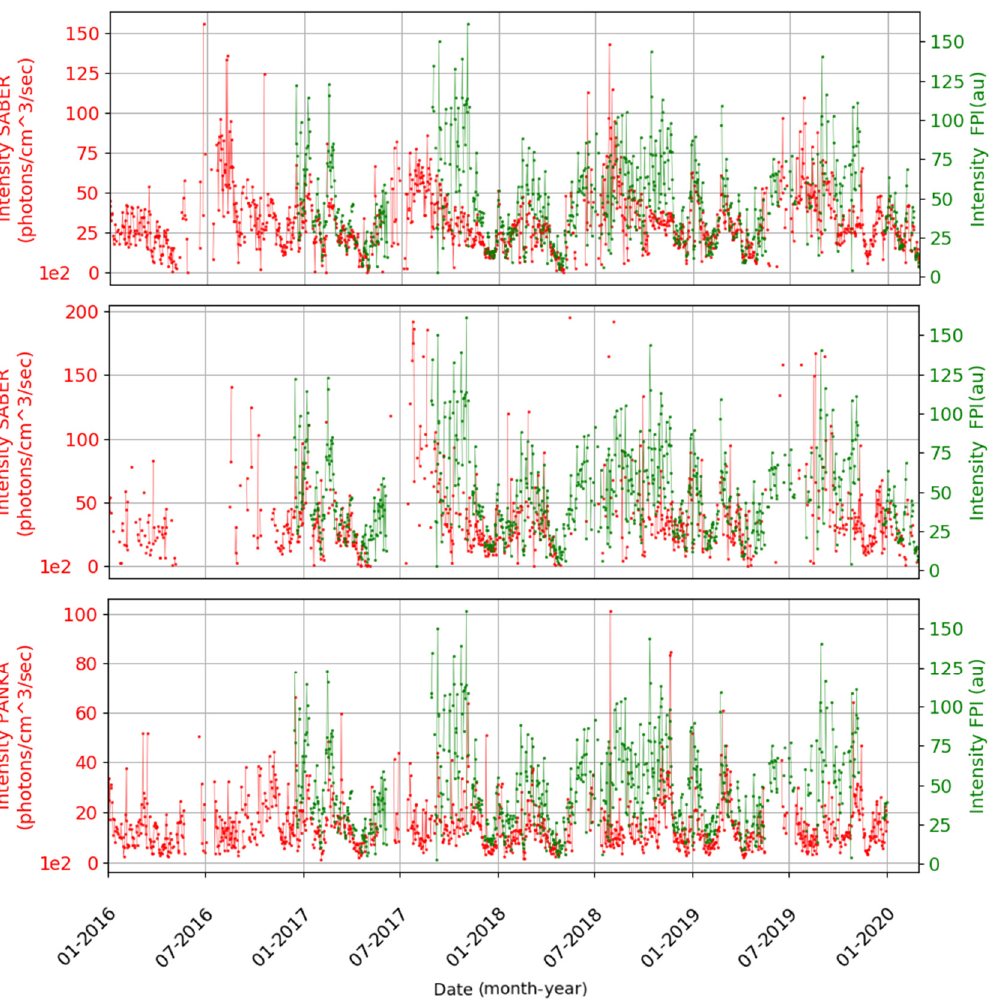
Figure 8. Dynamics of the 557.7 nm line intensity observed with Fabry–Pérot interferometer (green) and the 557.7 line intensity integrated in height as calculated from SABER data (red) in 2016–2020 above GPO in Tory, nighttime. The top panel presents data calculated using [20], the middle panel presents data calculated using [24], and the bottom panel presents data calculated using [25].